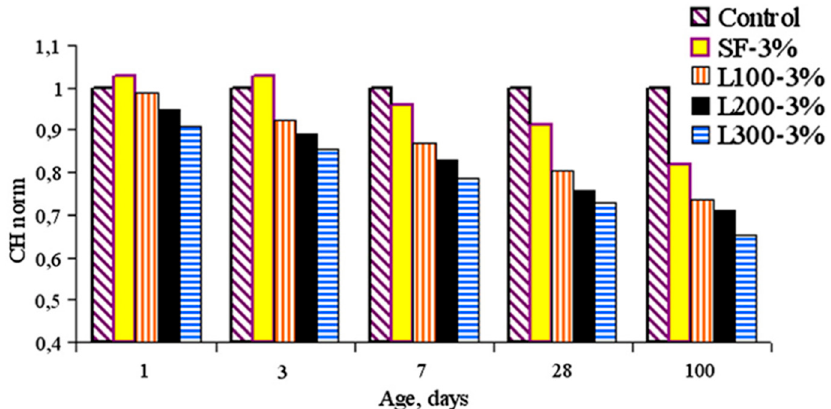
Figure 3. Normalized calcium hydroxide content of paste SF: silica fume and L100, L200, and L300 are nanoparticle SiO 2 types. Reprinted/adapted with permission from [73]. 2023, Cement and Concrete Research